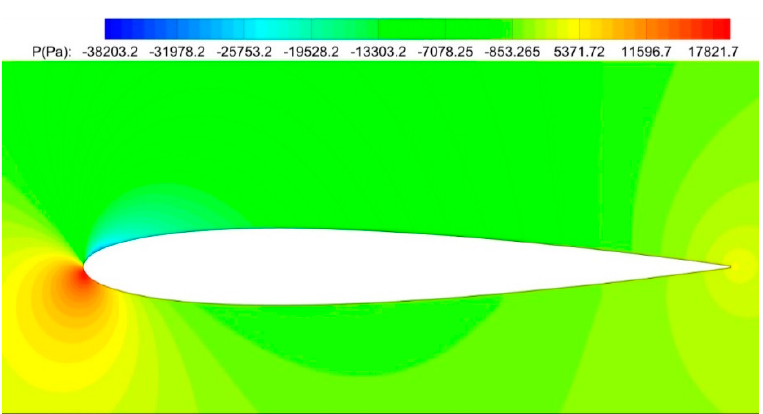
Figure 15. 4° angle of attack, pressure distribution of grooves on the suction side. Figure 16. 4° angle of attack, pressure distribution of standard NACA0012 airfoil.